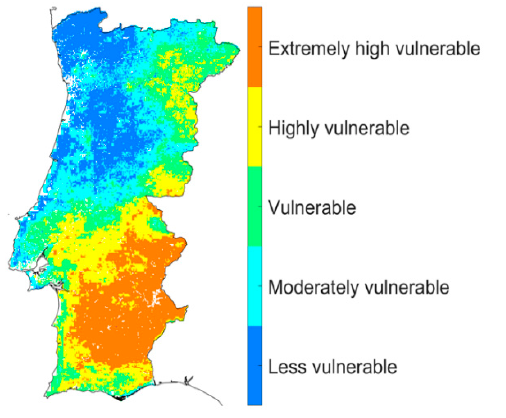
Figure 2. Classes of vulnerability of the main crops to